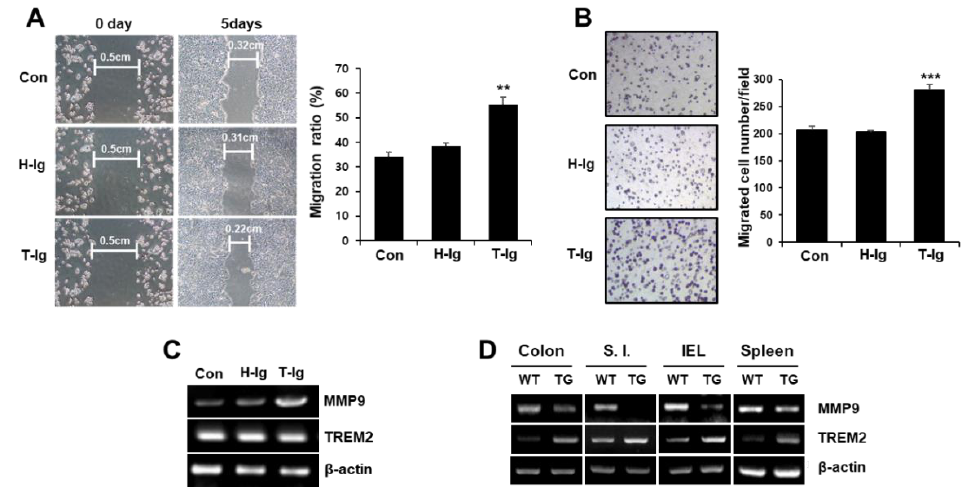
Figure 2. Inhibition of TREM2 enhances the migration of HT29 cells. ( A ) HT29 cells (1 × 10 5 cells) treated with h-Ig or T-Ig (2 µ g / mL) were plated in each well of six-well plates and allowed to grow to confluence for 24 h. Confluent monolayers were scratched with a pipette tip and cultured for 5 days. The scratch wound areas were quantitated from the photographs using a computer image analysis system. The migration ratio was calculated and represented as bar graphs. ( B ) Matrigel invasion assays were performed as described in the Materials and Methods, and the results are expressed as a bar graph representing the mean number of invaded cells. ( C ) Expression of MMP9 in HT29 cells ( D ) and cells isolated from various tissues of WT littermate and TREM2-TG mice was analyzed by RT-PCR. The data are representative of three independent experiments (** p < 0.01, *** p < 0.001).